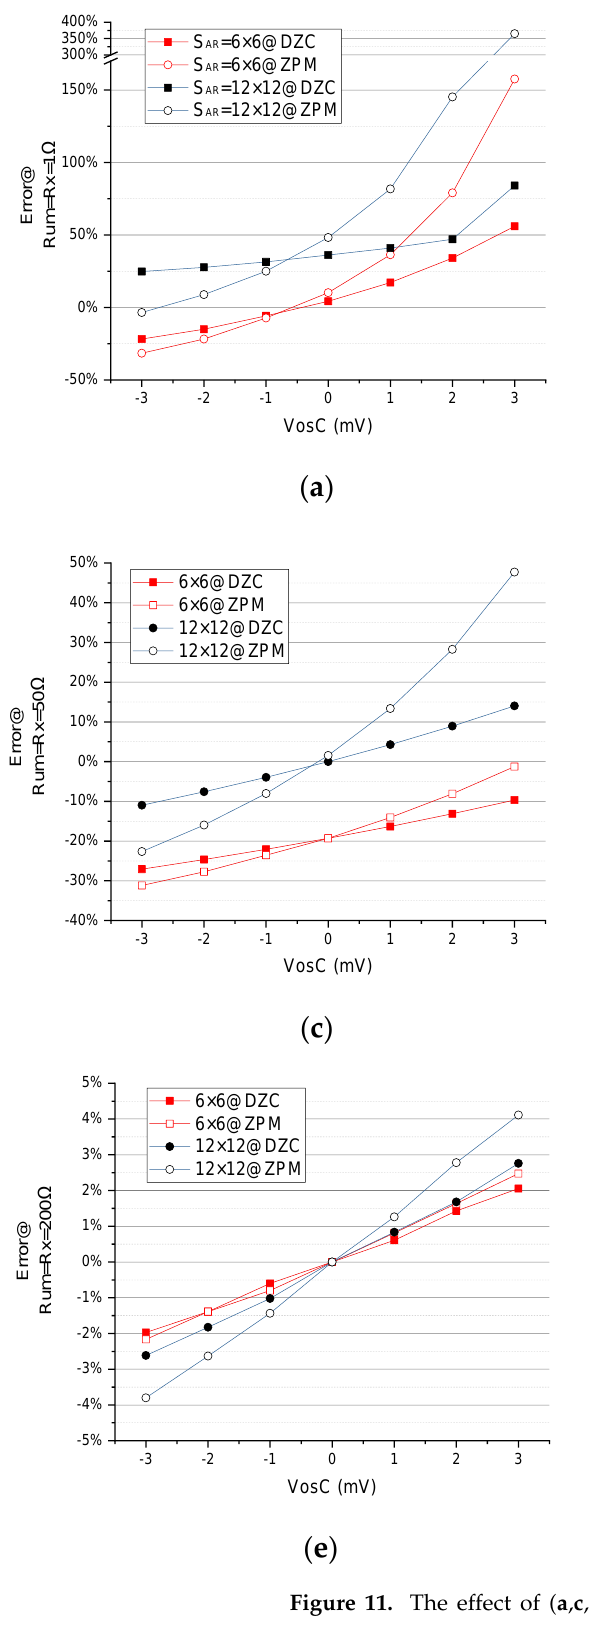
( b ) Figure 12. EGaIn based 4 × 4 flexible RSA ( a ) on flat surface and ( b ) on bending surface.